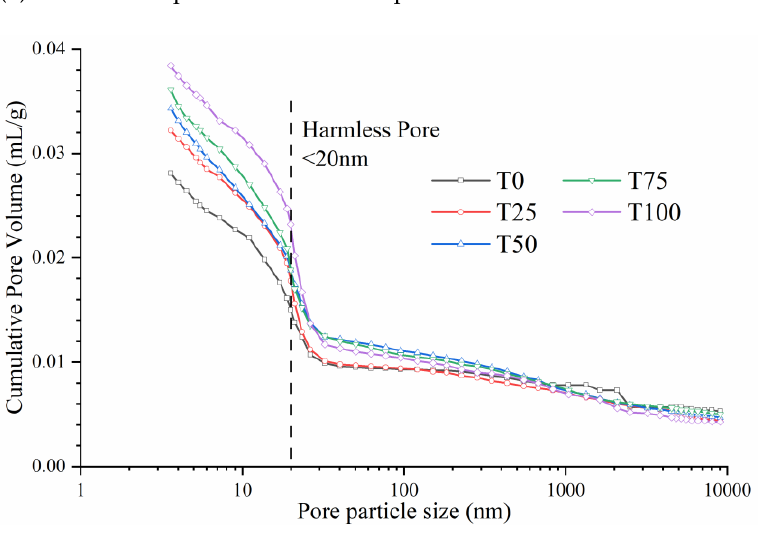
Figure 10. Pattern of particles packing model of two aggregates. ( a ) river sand ( b ) iron tailing sand.